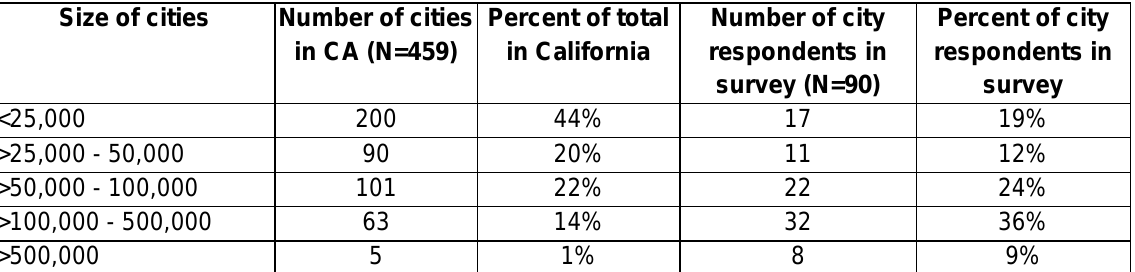
Table A1.1: Distribution of California cities by size (based on US Census 2012) and of respondents’ locations (based on reported affiliated city size)